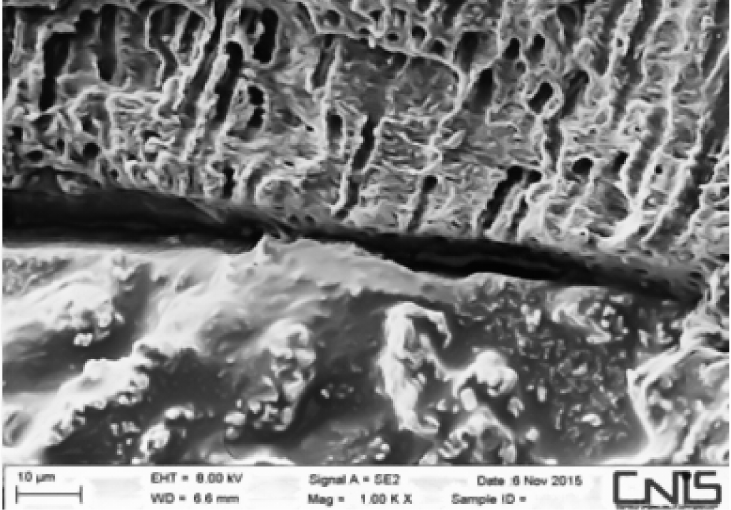
Figure 6. Interface between dentin and sealant. Section of coronal third T system.